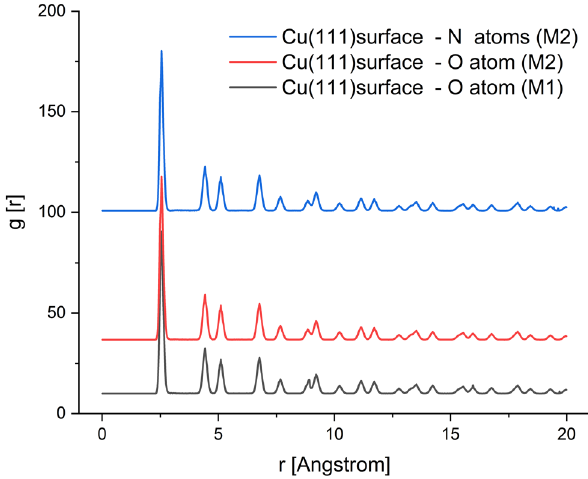
Figure 5: Probability of adsorption energy distribution curves for Cu ( 111 ) / M1 or M2 + 200 water molecules/one inhibitor molecule ( either M1 or M2 molecule ) /25 ethanol molecules and 60 hydronium + 30 sulfate - simulated corrosion media obtained via MC calculations.